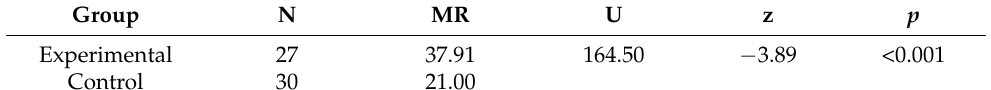
278 Table 6. Results of the t-test of the EXPL scores.